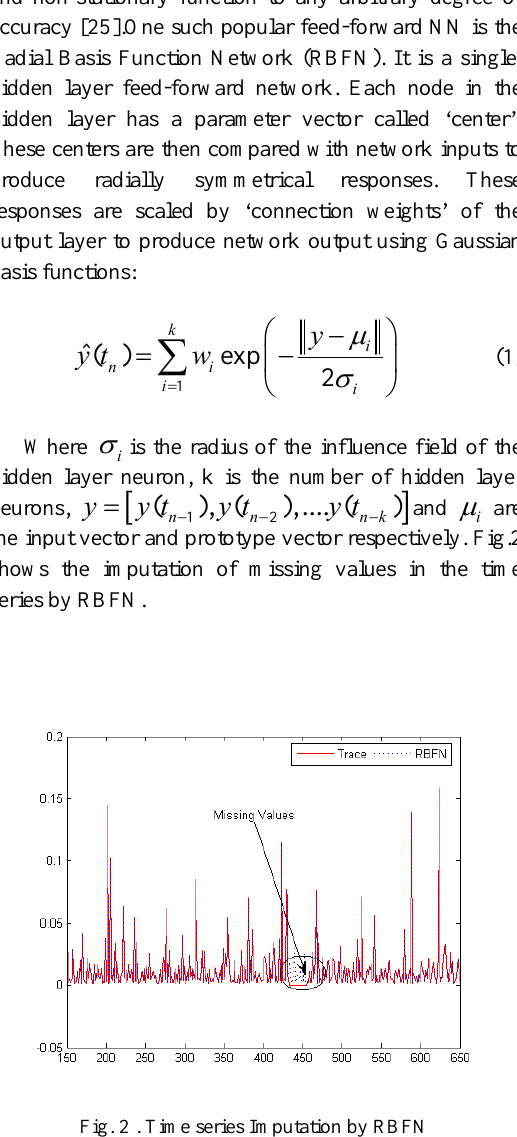
Fig. 2 . Time series Imputation by